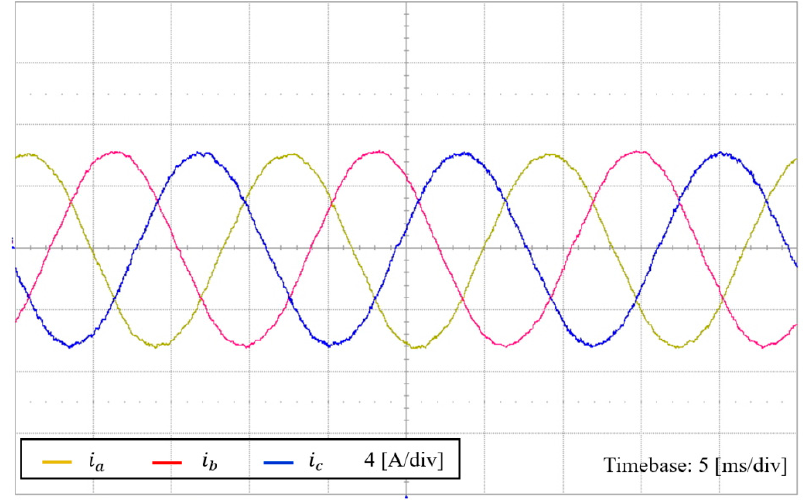
Figure 15. Experimental result of the inverter currents for the proposed control scheme under the ideal grid condition.